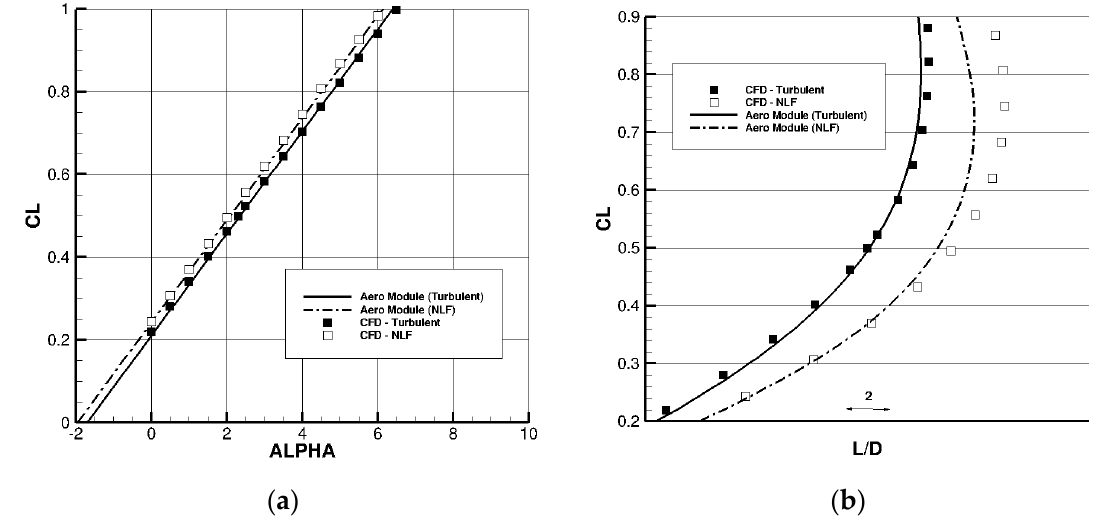
Figure 28. AG2-NLF configuration—global aerodynamic performances (M = 0.52, Re = 17.5 × 10 6 ). Lines—aerodynamic module; symbols—CFD. ( a ) C L ( α ). ( b ) C L (LoD).